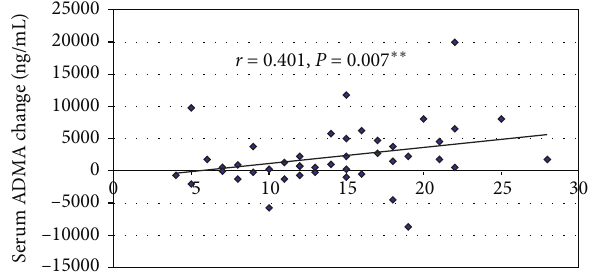
Figure 4: Correlation of the number of intradialytic hypotensive episodes with S. ADMA change.